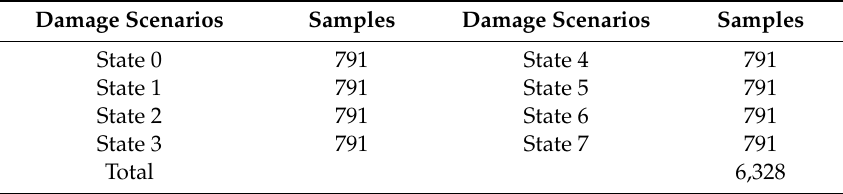
Table 3. Samples of the dataset E.